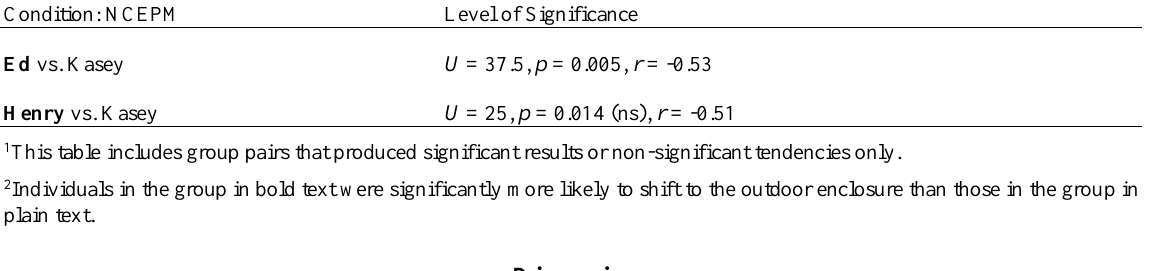
Stage 2 Results of Mann-Whitney Tests: Group Comparisons that Produced Significant Results 1,2 Condition: NCEPM Level of